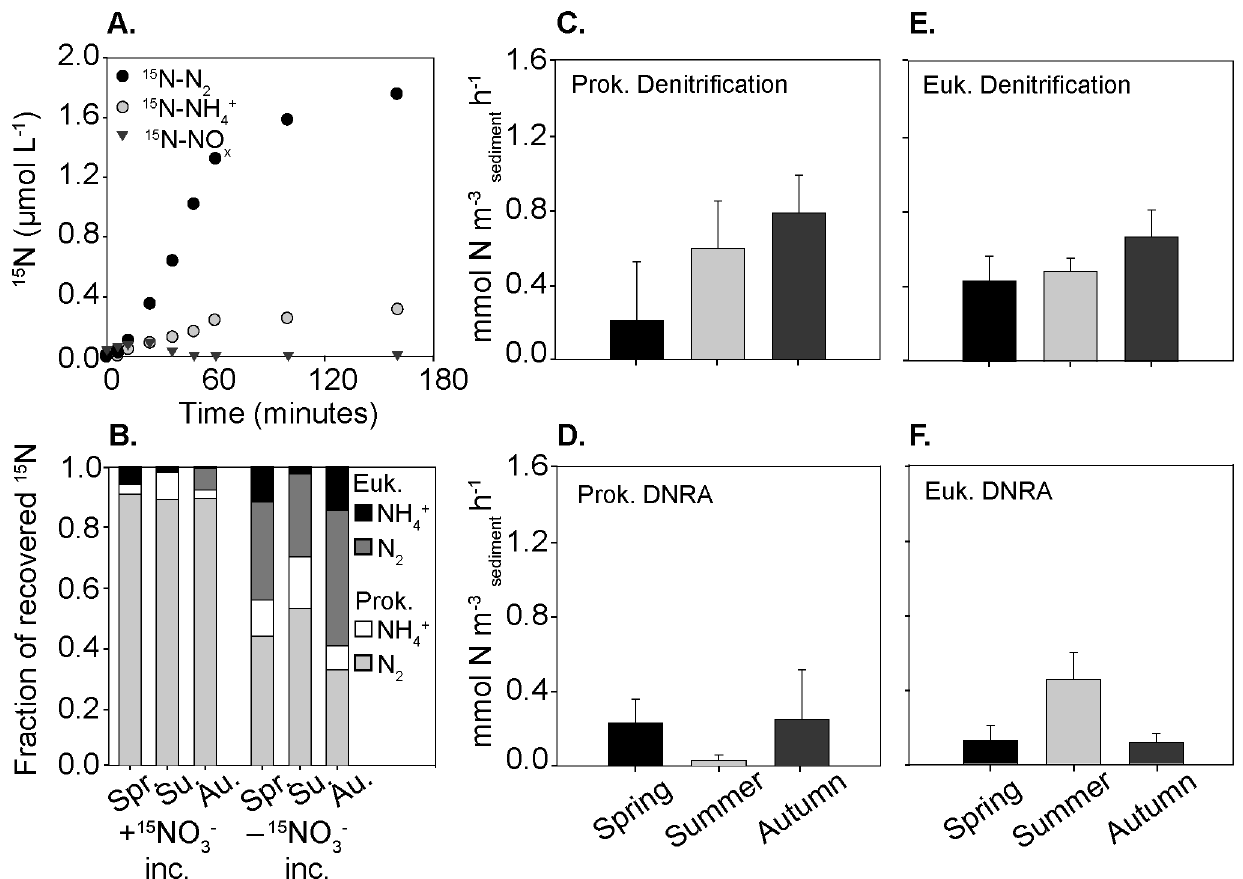
Figure 5. Respiration of stored intracellular nitrate by eukaryotes and prokaryotes. A) Example of the appearance of 15 N labeled compounds stored in the sediment during the secondary incubation to which no label was added (example from spring incubations) B) Comparison of the overall fraction of 15 N recovered as either N 2 or NH 4 + in both the 15 NO 3 2 incubation and the subsequent incubation with no additional 15 NO 3 2 and the partitioning between eukaryotes and prokaryotes C) Eukaryotic denitrification rates E) prokaryotic denitrification rates D) eukaryotic DNRA rates F) prokaryotic DNRA rates. Error bars are SD (n=3).